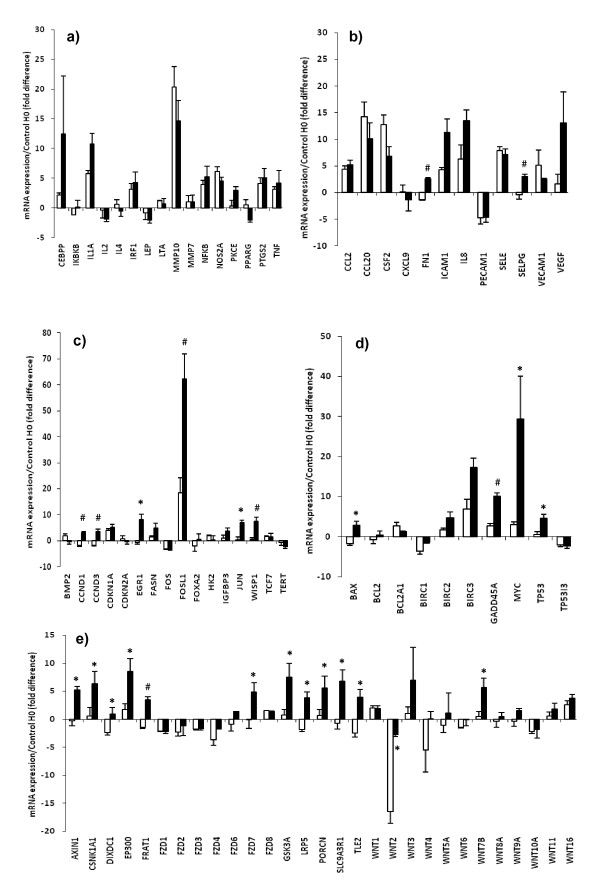
RT-PCR array. Effect of stretch (5 minutes, 2.5 × basal tone) on the early mRNA expression (3 hours after stretching) of genes implicated in (a) cell inflammation, (b) cell migration-adhesion, (c) cell growth-differentiation, (d) cell apoptosis, and (e) Wnt-mediated signal transduction. mRNA expression represents the ratio of experimental value/H0 value (fold difference). Filled bars, stretch; open bars, paired controls. Values are means ± standard error of the mean (n = 9). *P < 0.01; #P < 0.001 vs. paired control.